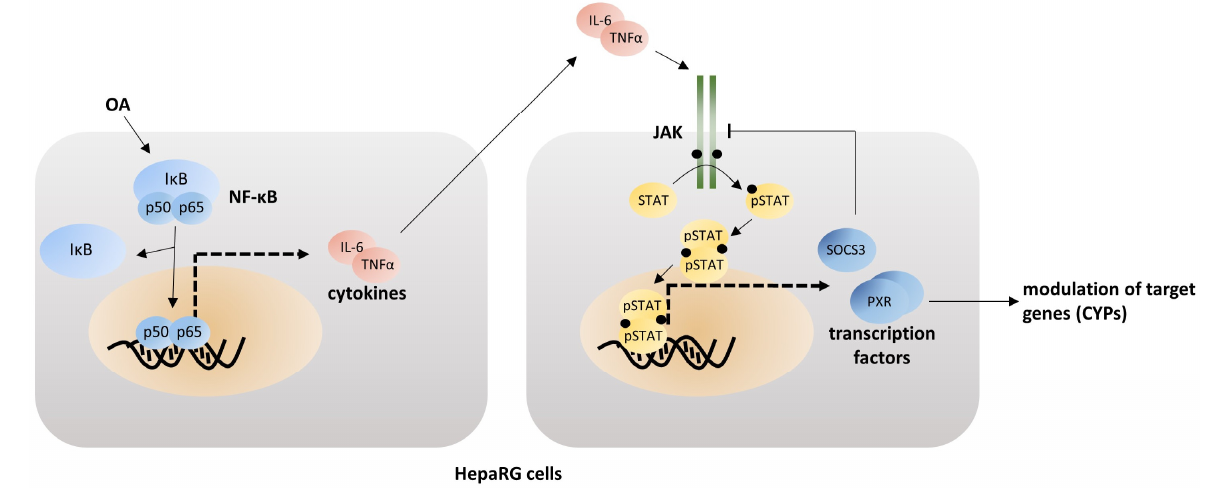
Figure 1. Proposed pathway for the interaction of OA with xenobiotic metabolism in HepaRG cells. OA is able to activate NF-κB, which leads to the translocation of p50 and p60 into the nucleus, where they act as transcription factors, leading to the expression of cytokines. The cytokines, such as IL-6 or TNFα, are released into the surrounding medium by the cells, where they can bind to a cytokine receptor of the same or a neighboring cell. The cytokine receptor is associated with a JAK. Binding of the cytokine leads to dimerization of the receptors, which in turn leads to the JAKs phosphorylating each other. STATs are then able to bind to the JAK, where they are also phosphorylated. Phosphorylated STATs dimerize and translocate into the nucleus, where they can act as a transcription factor to other proteins influencing the CYPs and to SOCS3, a direct target of the JAK/STAT signaling pathway, which is able to deactivate JAK signaling in a feedback loop.